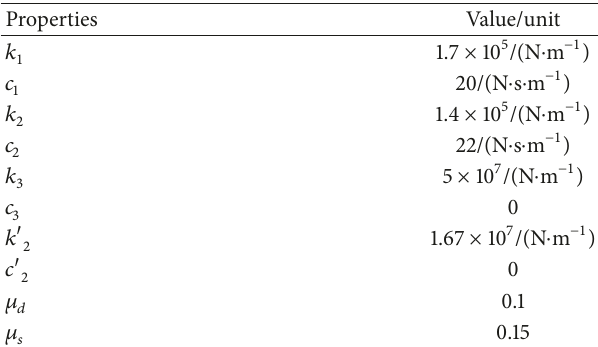
Table 2: Support parameters of the